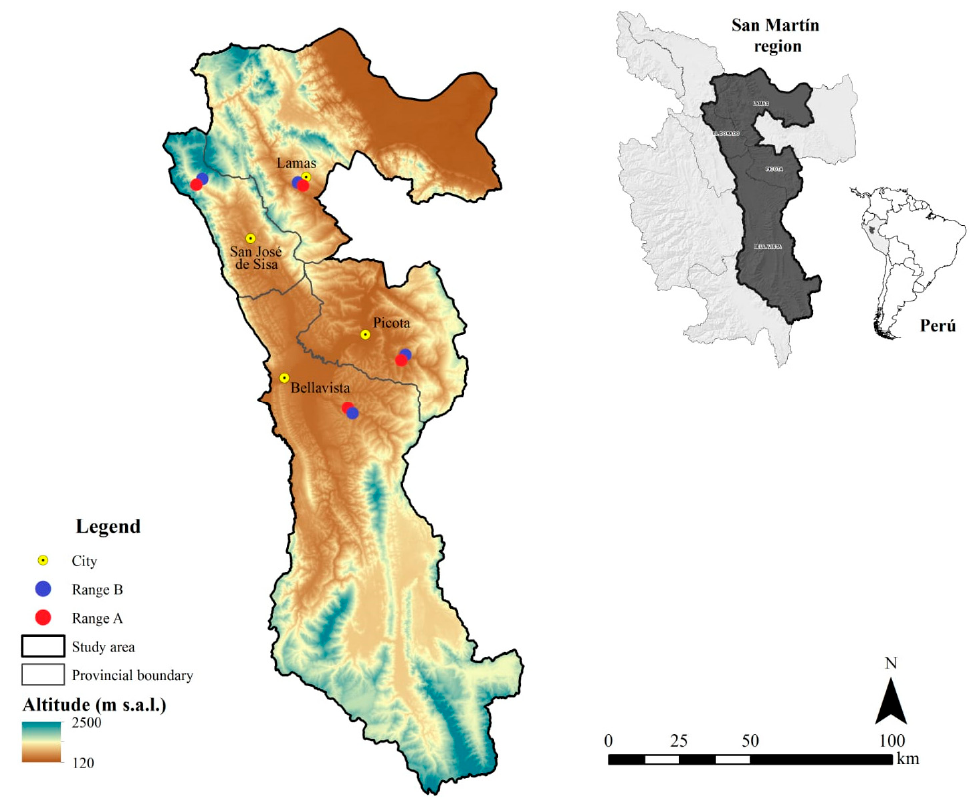
Figure 1. Spatial location of the eight sampled sacha inchi production plots, located in four localities of the San Martín region in Peru. Red points represent plots with plantations less than one year old, and blue points represent those older than three years old.